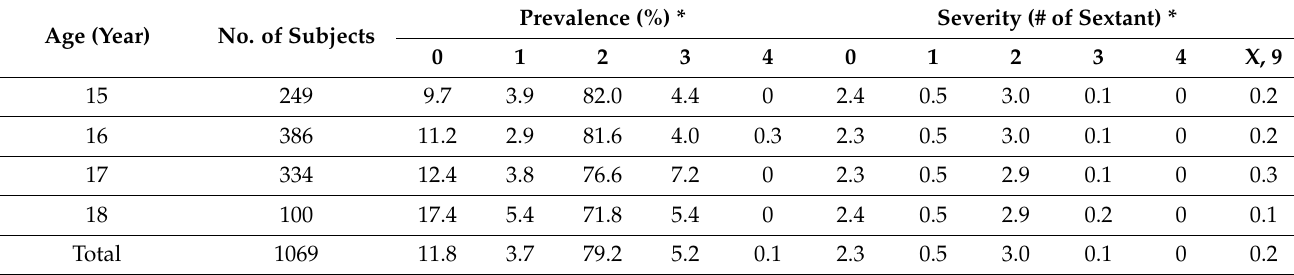
had 1.1 times higher CPI scores than those individuals who did. Oher factors, including demographics, family background, lifestyle, oral hygiene habits, and dental awareness, did not have statistically significant odds ratios. For the LA status, only two factors obtained significance level. One factor was attending school, and the other was the frequency of dental visits. The students at vocational schools had 1.8 times higher LA scores than those students in regular high schools. Those students who frequently visited dentists due to dental problems had a 2.86 times higher (95% confidence interval: 1.01, 8.11) chance of loss of attachment than those students who did not see dentists at all. None of the CPI and LA risk indicators showed a significant trend for prevalence or severity in the multivariate regression analyses. Table 1. The prevalence and severity of CPI † among Taiwanese students aged 15–18 years.